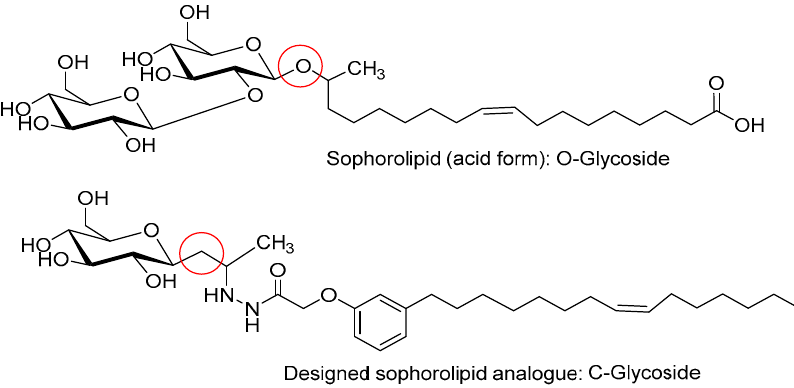
Figure 1. Molecular structure of sophorolipid and the designed saphorolipid analogue.